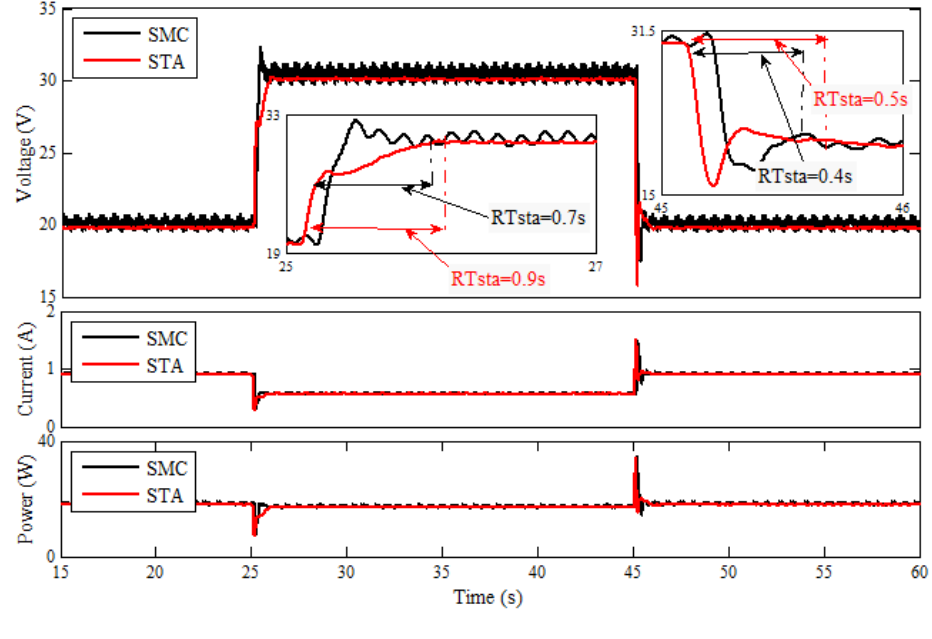
Figure 14. Boost converter output voltage, current, and